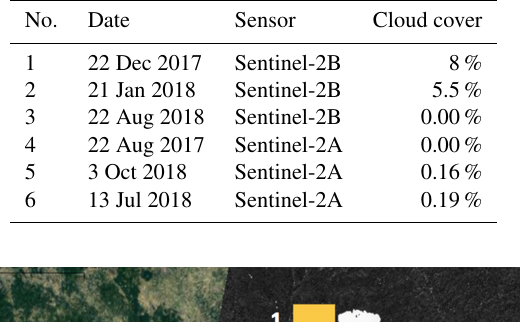
Table 5. Sentinel-2 dataset.